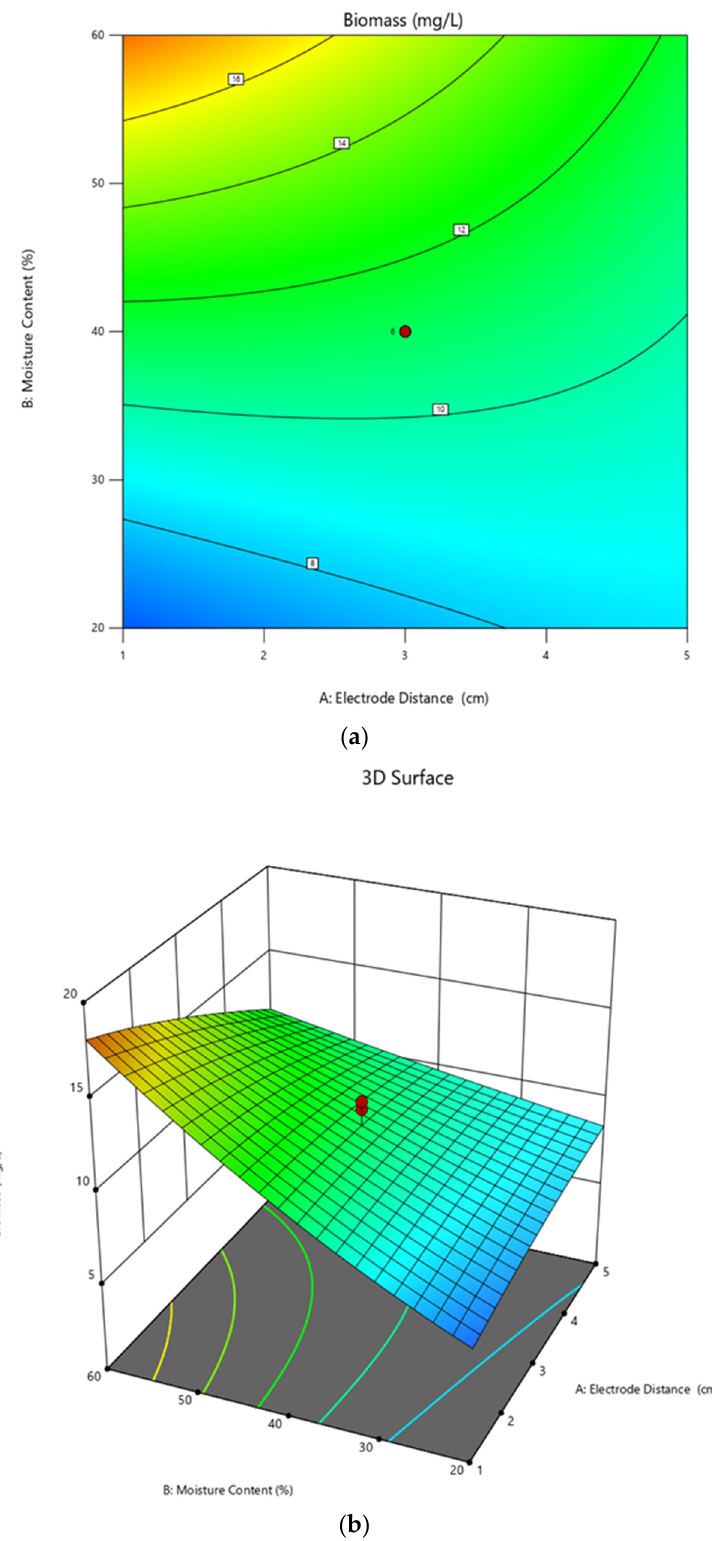
Figure 3. ( a ) Contour plot and ( b ) response surface plot of biomass as a function of moisture content relative to electrode distance.